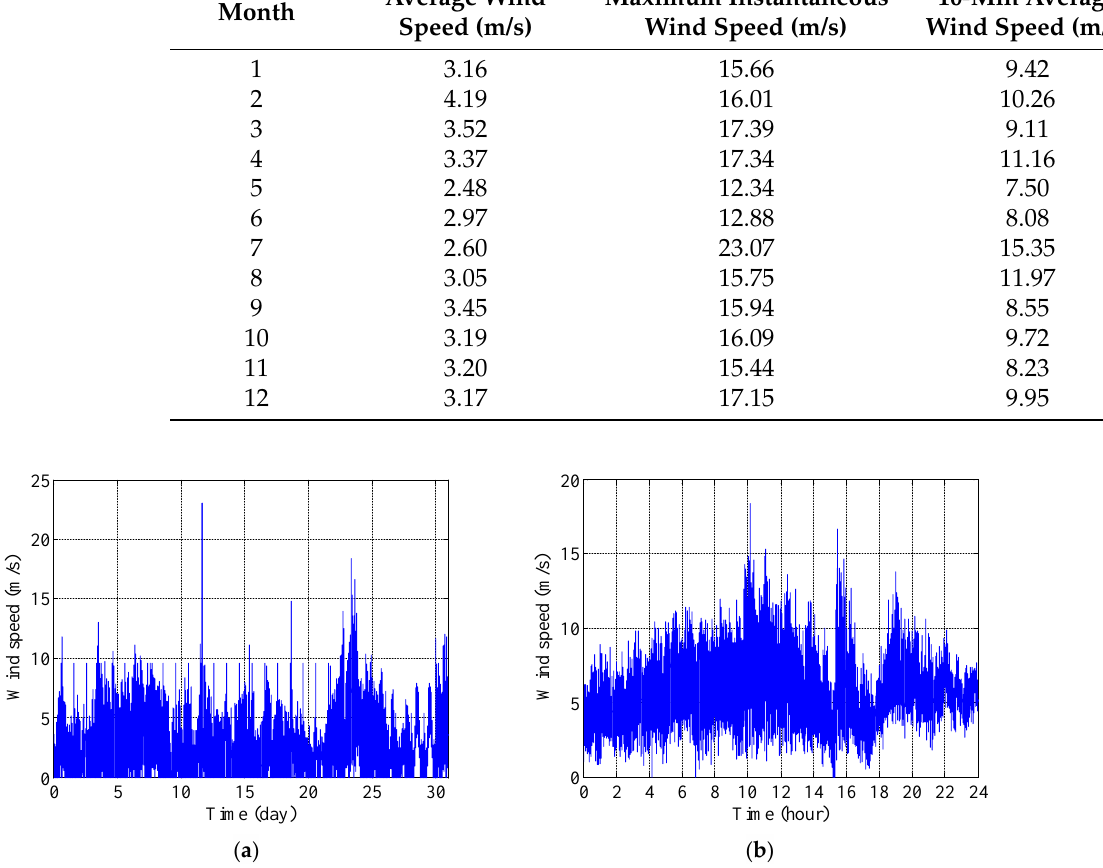
Figure 5. Wind speed – time curves for regular wind. ( a ) 1 – 31 July. ( b ) 24 July.